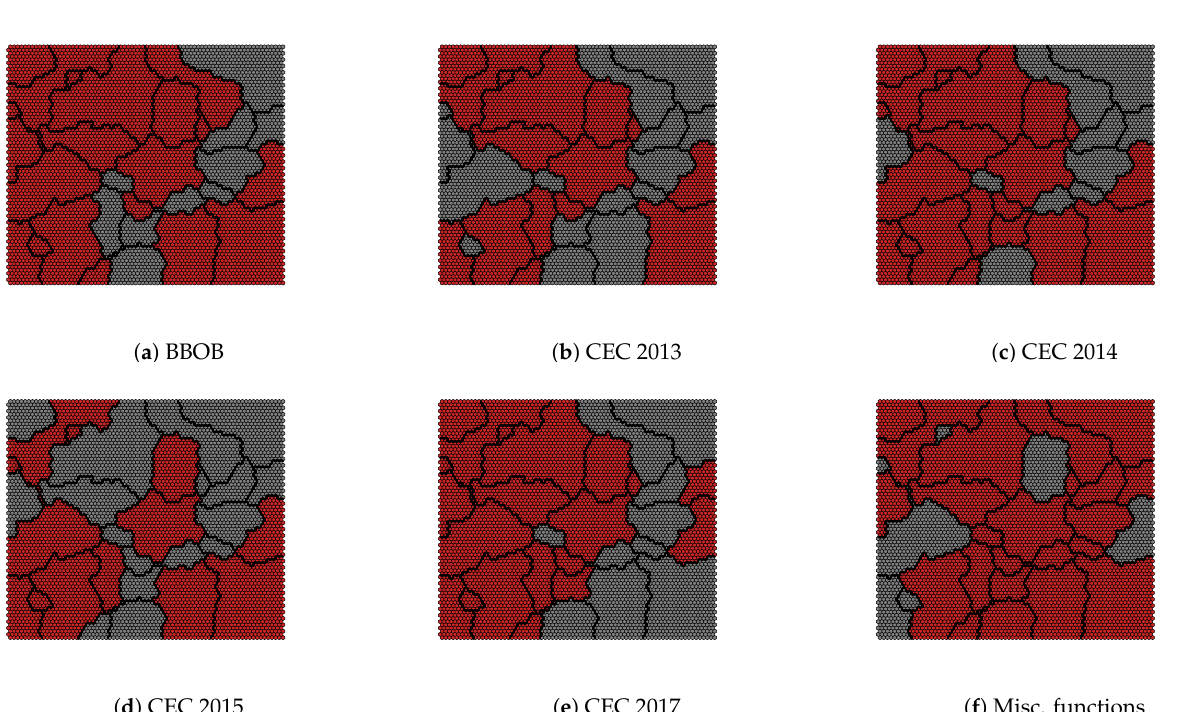
Figure 6. Coverage of the problem space for each of the benchmark suites. Illustrated by highlighting in red which clusters contain functions from the particular benchmark